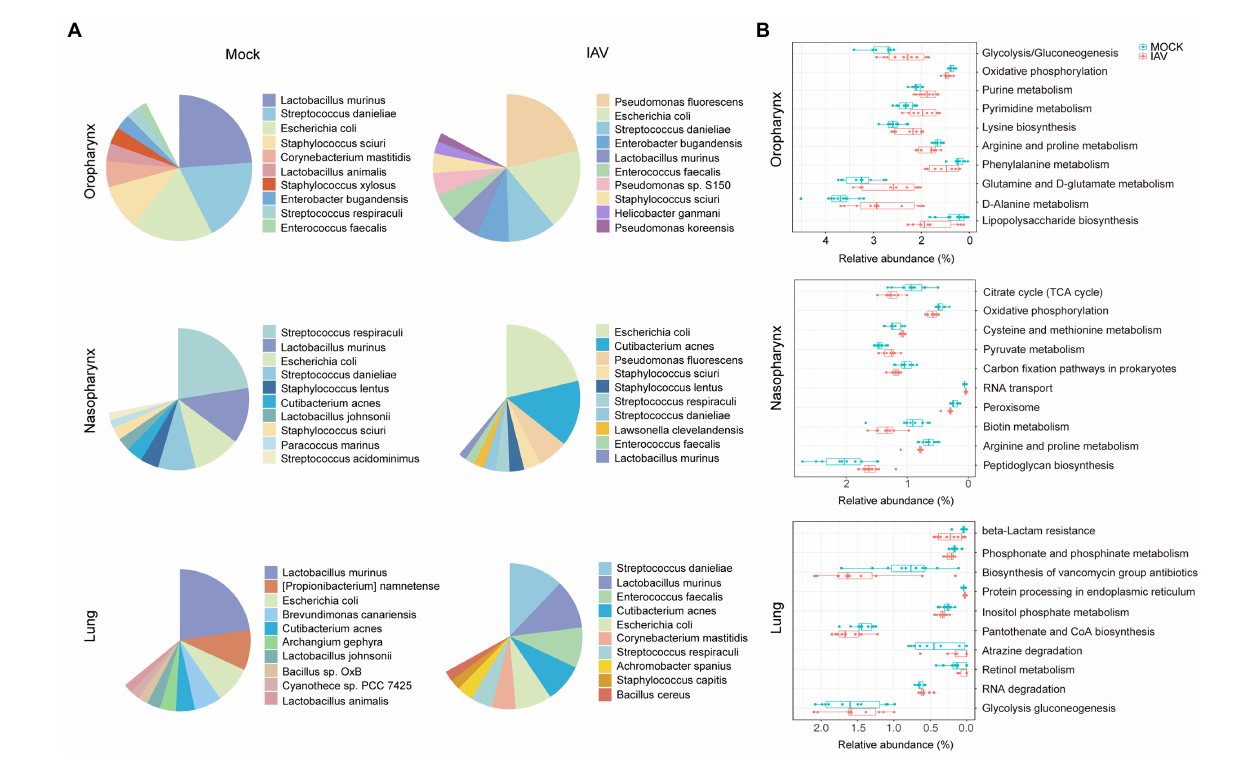
FIGURE 3 Characterization of species-level bacteria and functional composition of respiratory tract microbiota during IAV infection. (A) Relative abundance of the top 10 bacterial species of oropharyngeal, nasopharyngeal and lung microbiota in mock and IAV groups. (B) Top 10 significantly altered metabolic pathways of oropharyngeal, nasopharyngeal and lung microbiota between mock and IAV groups. Pathway abundance prediction by PICRUSt2. n = 10 per group. The relative abundance on the x-axis represents the ratio of the corresponding functional abundance to all predicted functional